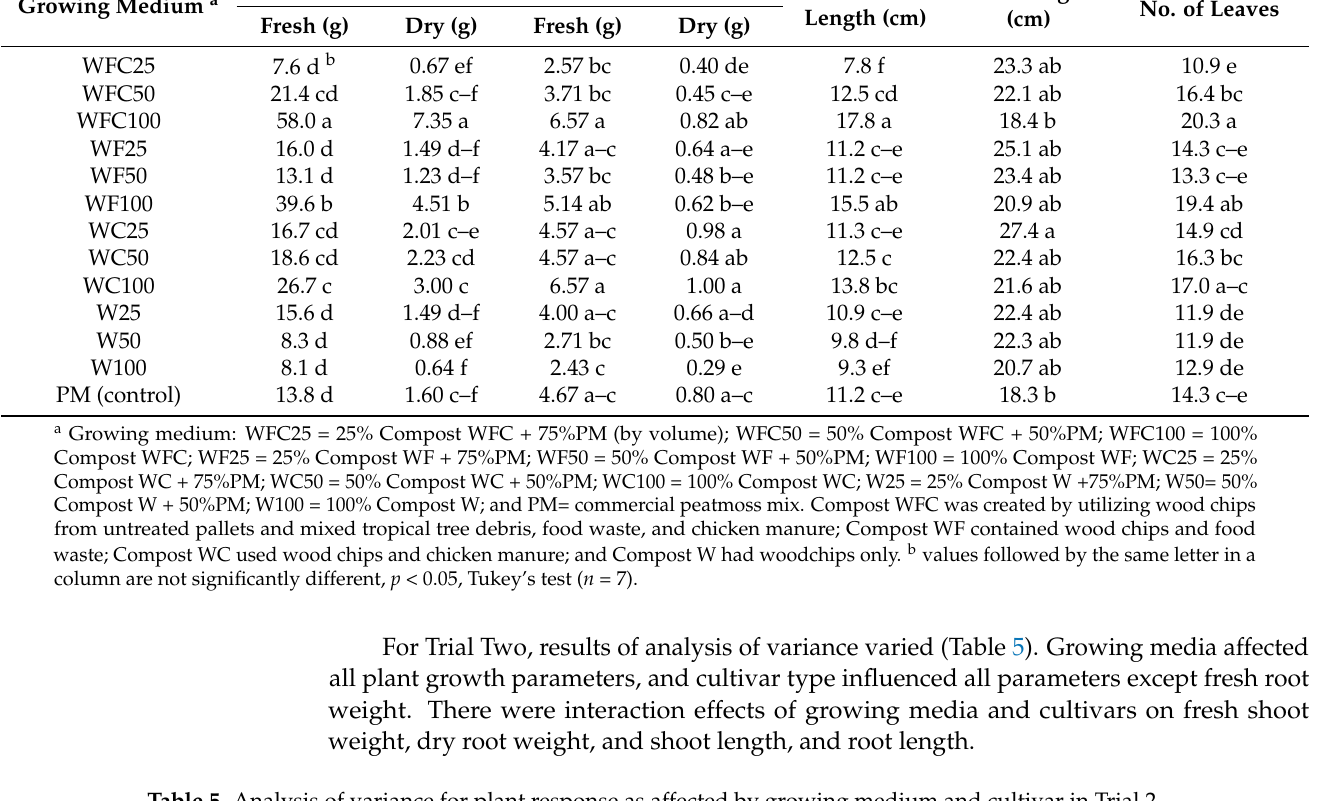
Table 5. Analysis of variance for plant response as affected by growing medium and cultivar in Trial